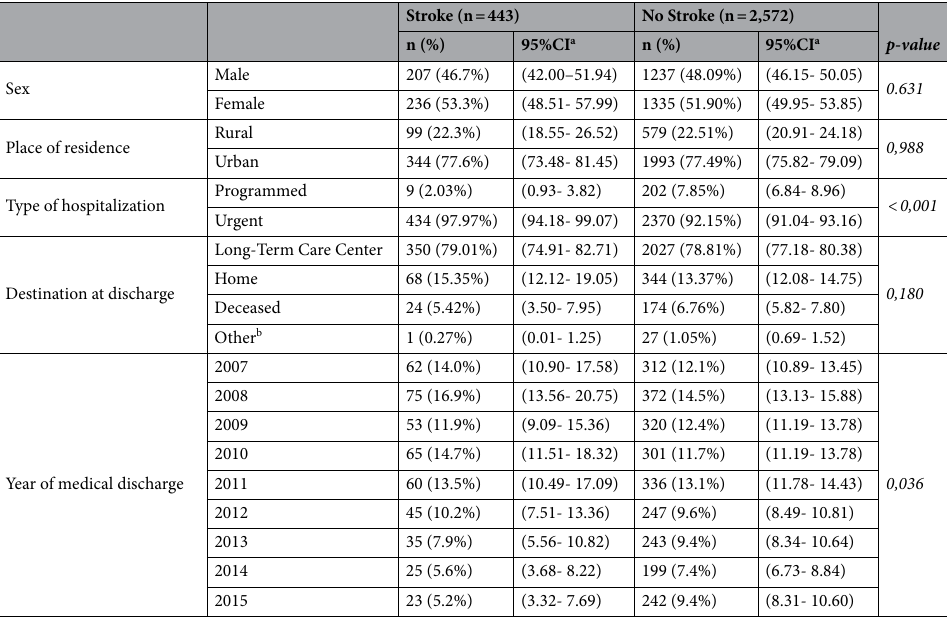
Table 2. Comparison of cases with stroke versus other cases of delayed discharge for non-clinical reasons: characteristics of the patient and the context of care. Cantabria (Northern Spain), 2007–2015. a 95%CI, 95% confidence interval; b nursing homes for people with dependency.